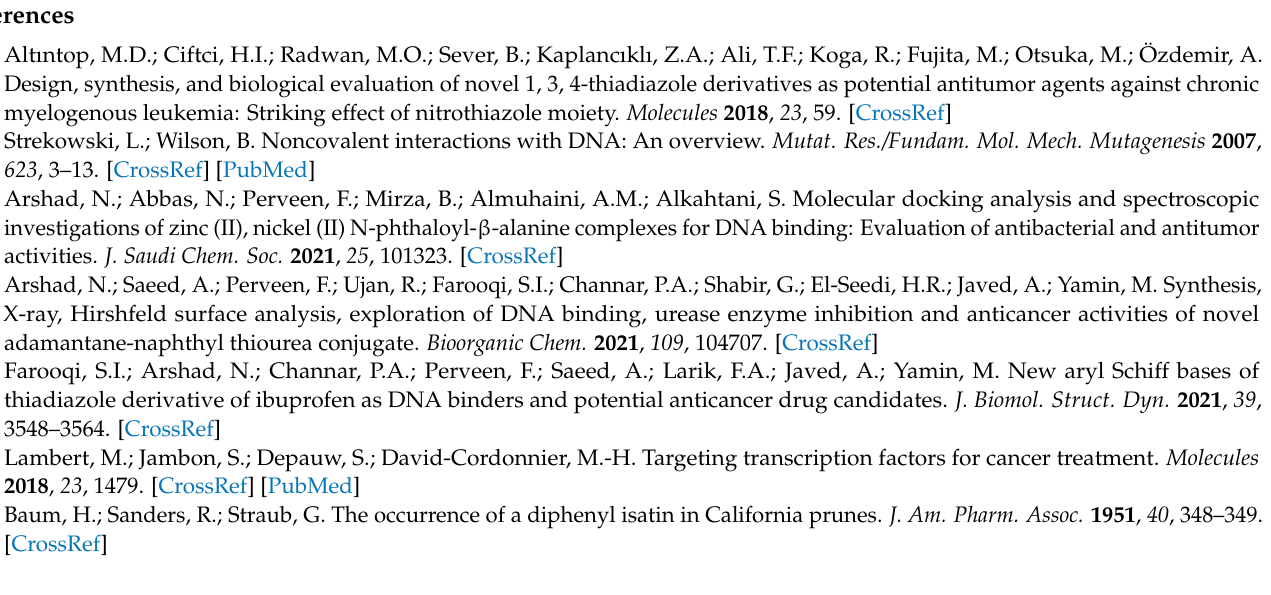
Supplementary Materials: The following supporting information can be downloaded online. Figure S1: FT-IR spectrum of IST-01; Figure S2: 1 H-NMR spectrum of IST-01; Figure S3: 13 C-NMR spectrum of IST-01; Figure S4: FT-IR spectrum of IST-02; Figure S5: 1 H-NMR spectrum of IST-02; Figure S6: 13 C-NMR spectrum of IST-02; Figure S7: FT-IR spectrum of IST-03; Figure S8: 1 H-NMR spectrum of IST-03; Figure S9: 13 C-NMR spectrum of IST-03; Figure S10: FT-IR spectrum of IST-04; Figure S11: 1 H-NMR spectrum of IST-04; Figure S12: 13 C-NMR spectrum of IST-04; Figure S13: Concentration profiles of the synthesized compounds; Figure S14: Absorbance vs. Concentration graphs for the determination of molar extinction co-efficient of (a) IST-01, (b) IST-02, (c) IST-03, and IST-04; Figure S15: Overlay of cyclic voltammogram for compounds (a) IST-01, (c) IST-02, (e) IST-03, (g) IST-04 and (b,d,f,h) their DNA bound complexes at different scan rates. Arrow direction indicated increase in the scan rate as 0.03, 0.05, 0.07, 0.9, 0.11, 0.13 V/s; Figure S16: Plot of I p vs V 1/2 for (a) IST-01, (b) IST-04, (c) IST-04, (d) IST-04 in the (1) absence and (2) in the presence of 60 µ M DNA at scan rate of 0.03, 0.05, 0.07, 0.09, 0.11, 0.13 V/s; Figure S17: Percentage cytotoxicity of compounds (a) IST-01, (b) IST-02, (c) IST-03 and (d) IST-04 on HeLa cells. PBS with 10% DMSO was used as solvent control and Doxorubicin HCL was used as positive reference control; Figure S18: Percentage cytotoxicity of compounds (a) IST-01, (b) IST-02, (c) IST-03 and (d) IST-04 on MCF-07 cells. PBS with 10% DMSO was used as solvent control and Doxorubicin HCL was used as positive reference